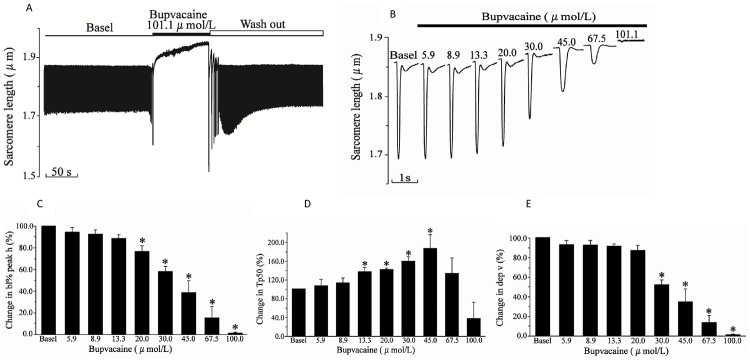
Bupivacaine mediated a concentration-dependent depression on contraction of rat cardiomyocytes.(A) Representative sarcomere-shortening trace before and after exposure to bupivacaine. Y axis: changing of sarcomere length recorded during myocyte contraction; X axis: perfusates. (B) Representative individual signal of cardiomyocyte sarcomere contraction in the presence of bupivacaine at different concentrations. (C), (D), and (E) Statistical analysis of effect of bupivacaine on bl% peak h, Tp50 and dep v. Data are the mean ± SD. *P < 0.05, vs. basal amplitude.